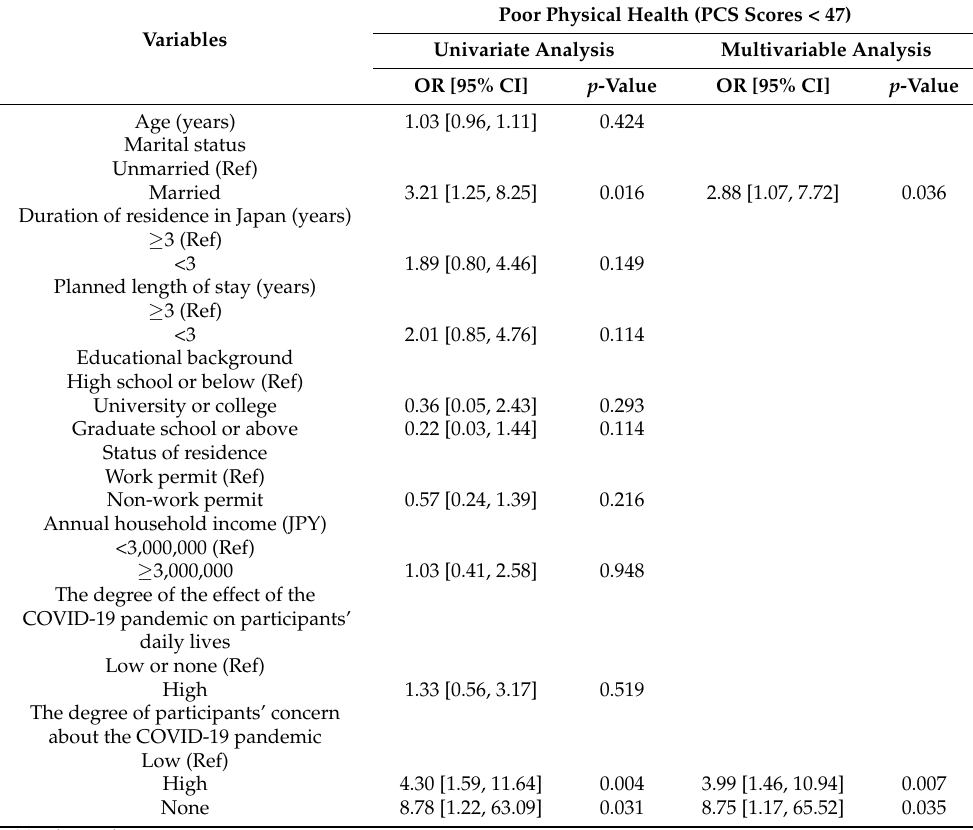
Table 3. Univariate analysis and multivariate logistic regression analysis of risk factors for poor physical health with PCS scores less than 47 (n =